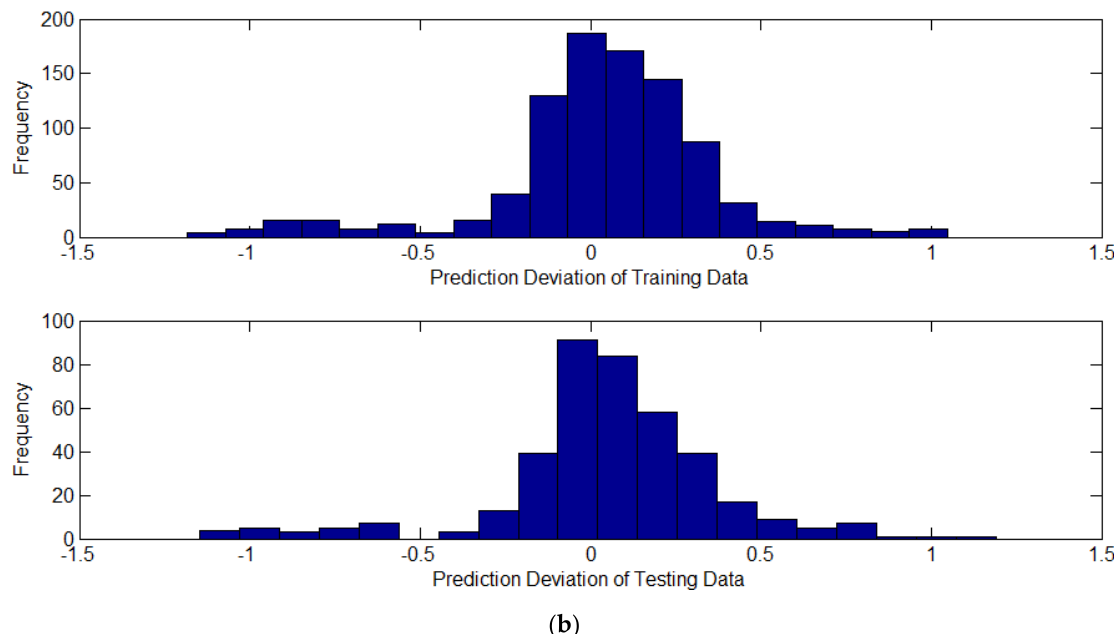
Figure 13. Details of the predicted and actual output data: ( a ) Prediction deviation and ( b ) Prediction Error Distribution.